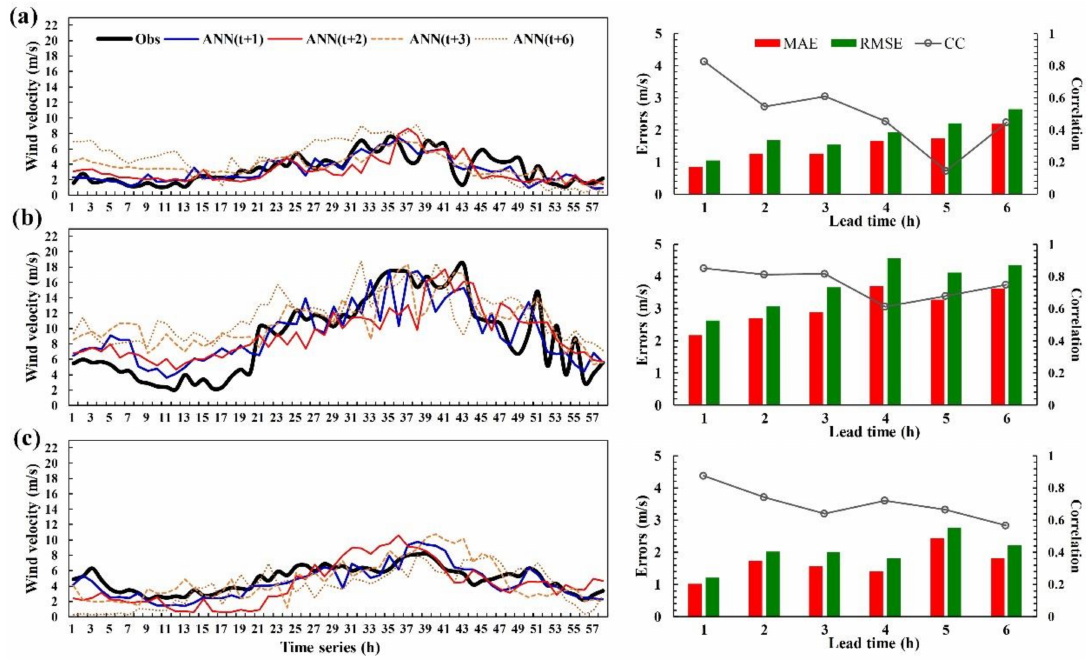
Figure 5. Comparisons of 1- to 6-h lead predictions for Soulik in 2013: ( a ) Hsinchu, ( b ) Wuqi, and ( c ) Kaohsiung